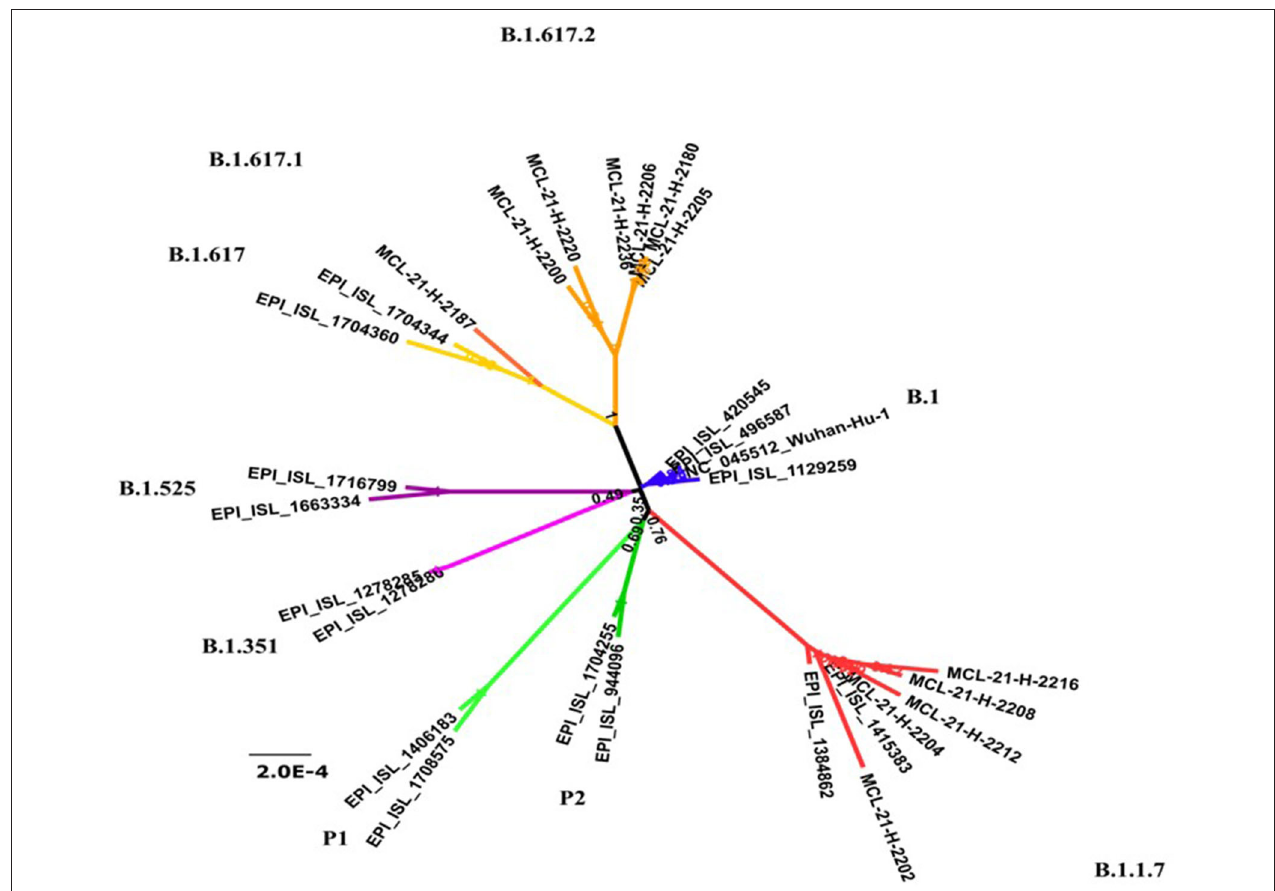
FIGURE 2 | Phylogenetic trees of recovered 12 severe acute respiratory syndrom coronavirus 2 (SARS CoV-2) sequences and GISAID representative sequences to depict the presence of different lineages of the virus in Chennai.